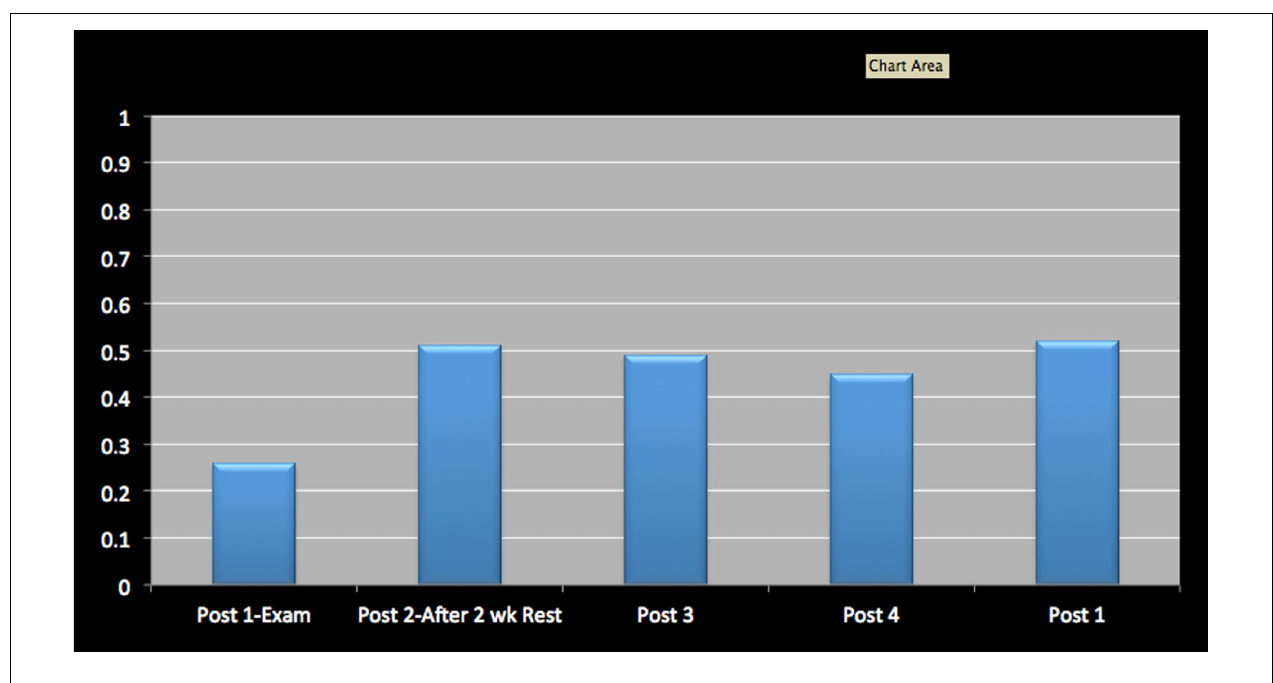
FIGURE 4 | Cognitive Efficiency on